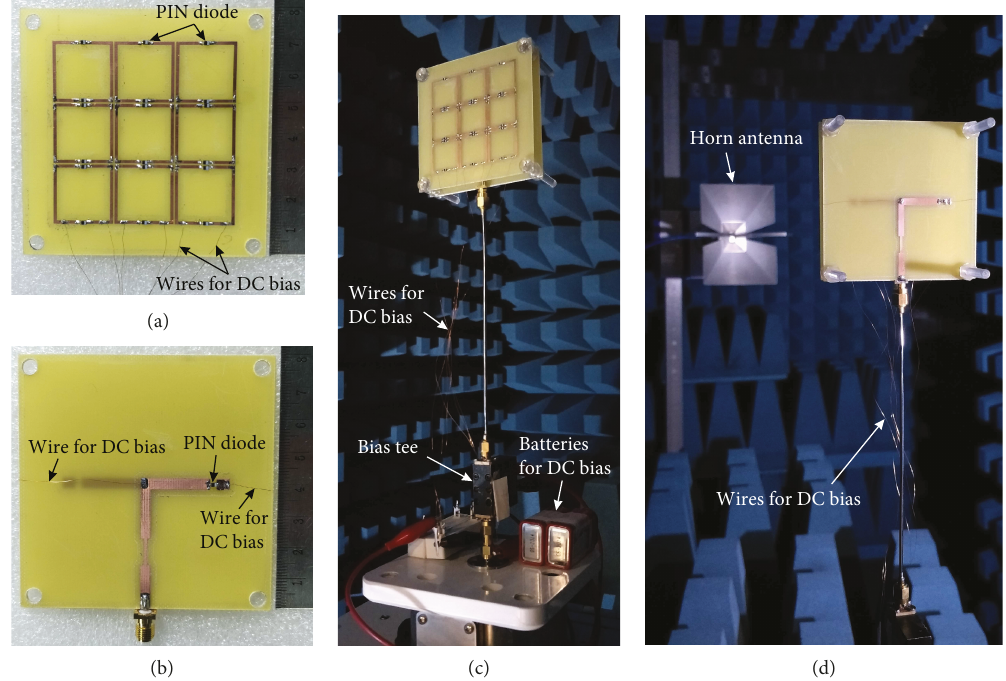
Figure 3: Prototype of the fabricated PIN diode-based recon fi gurable metasurface antenna: (a) top view of the recon fi gurable metasurface and (b) bottom view of the dipole excitation source. (c, d) Experimental setup during the measurement of the radiation patterns (gain) of the proposed recon fi gurable metasurface antenna.